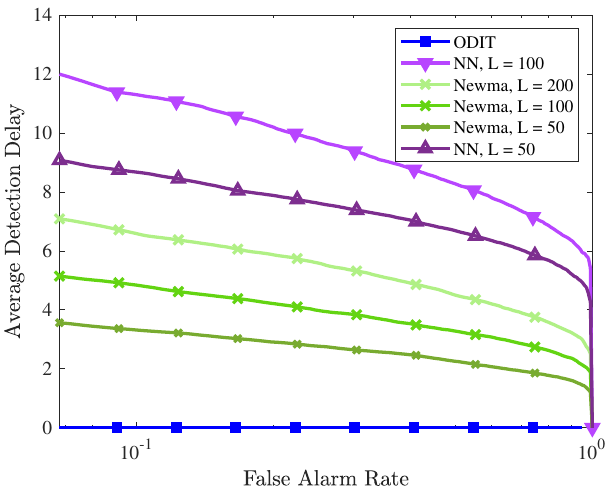
Figure 11. Performance evaluation of anomaly detectors in the botnet detection experiment in terms of the average detection delay vs.